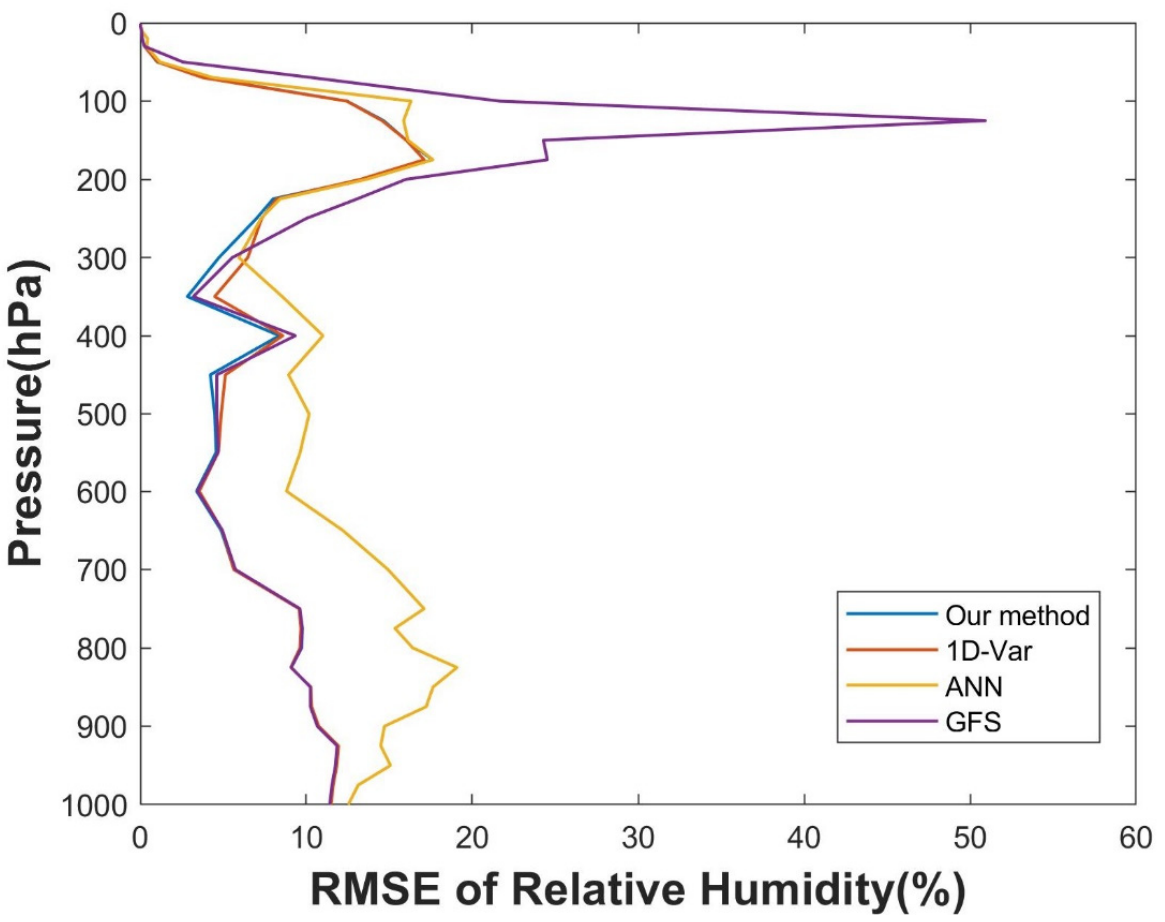
Figure 9. With ERA5 reanalysis data as the reference true value, the RMSEs of our method, GFS, 1D-Var, and ANN (1–1000 hPa).